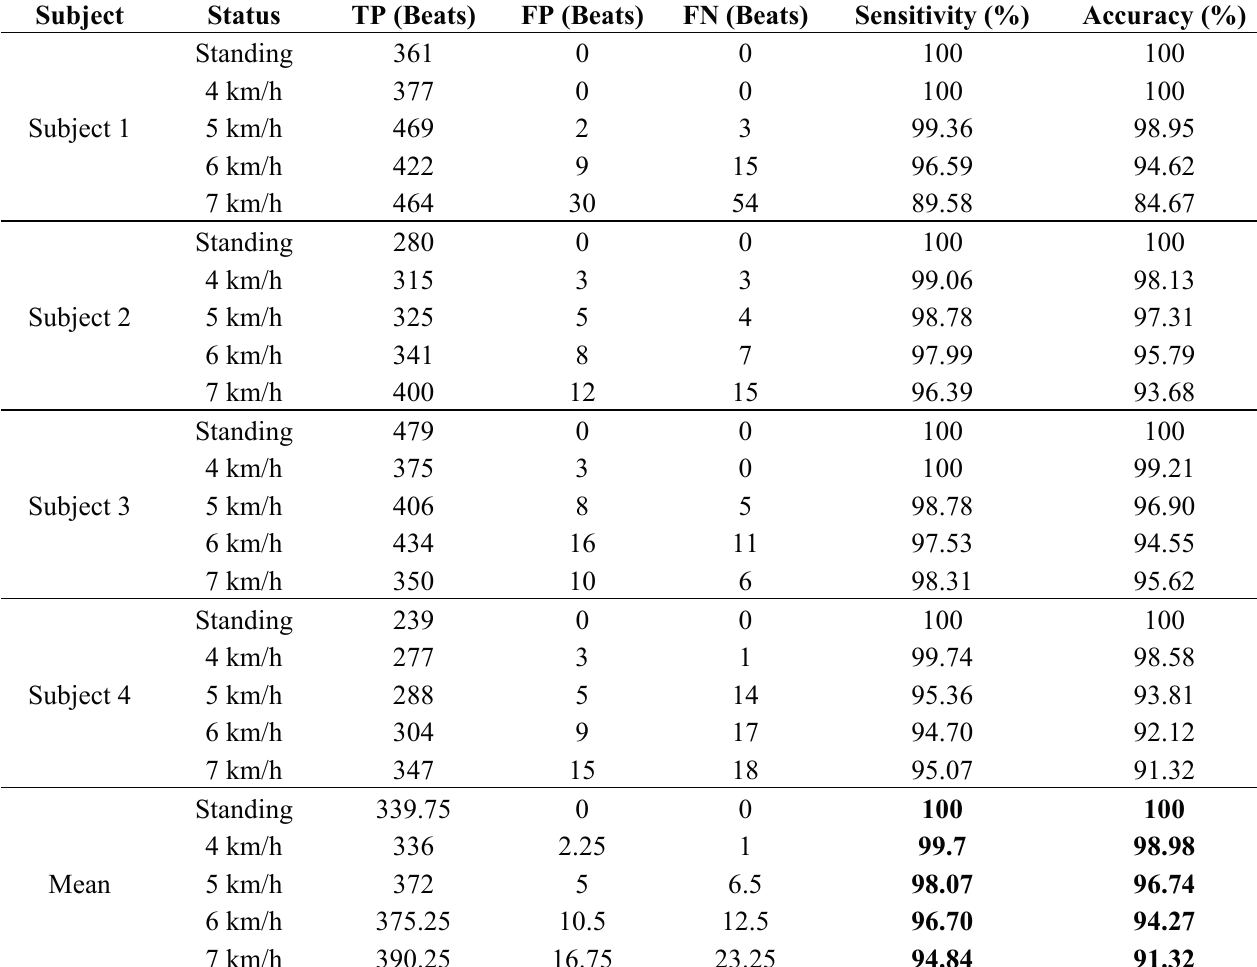
Table 1. Statistical results for QRS complex